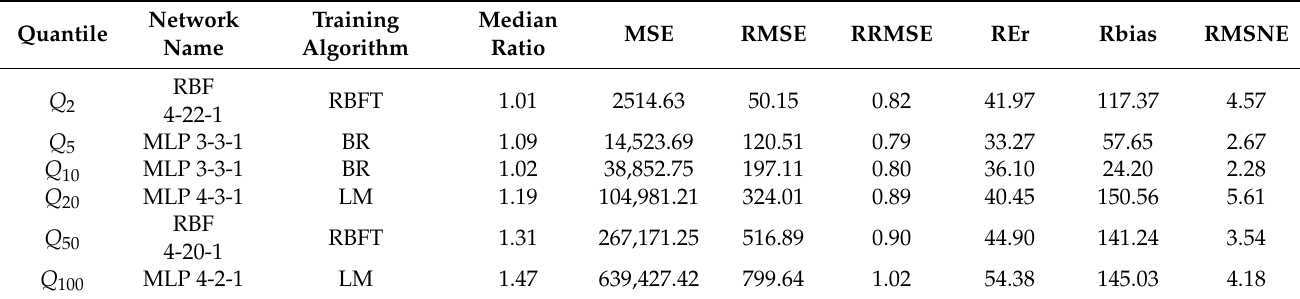
Table 2. Statistical evaluations of the best-performing ANN model for different quantiles.